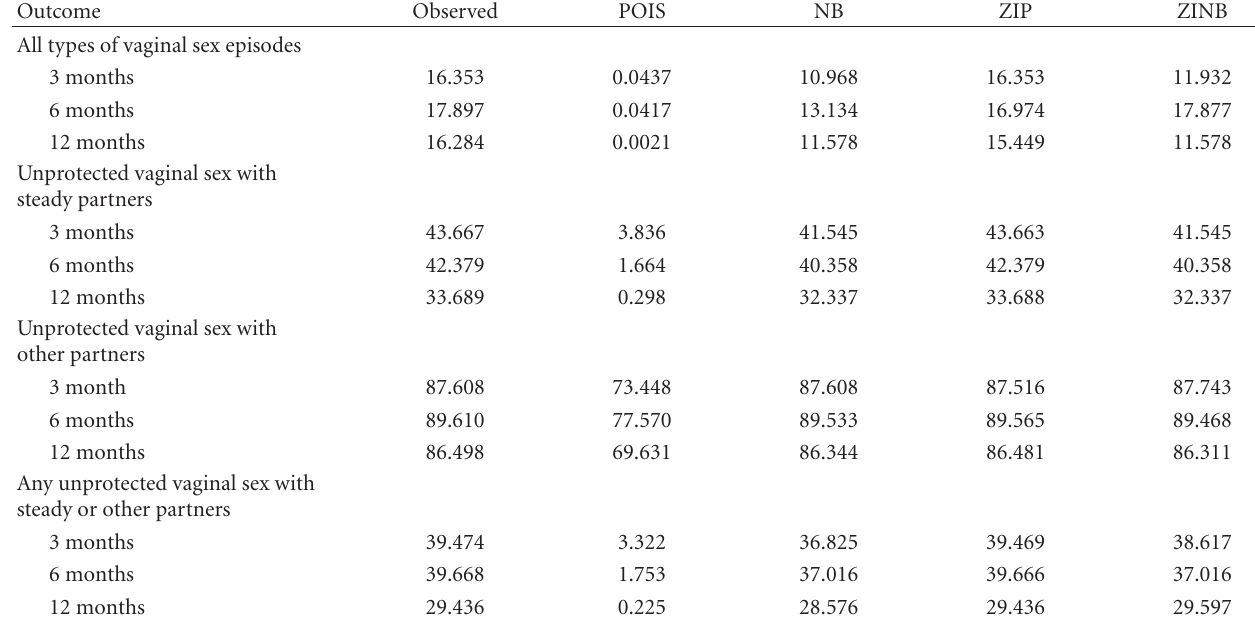
Table 3: Percentage of zeros captured by the POIS, NB, ZIP, and ZINB